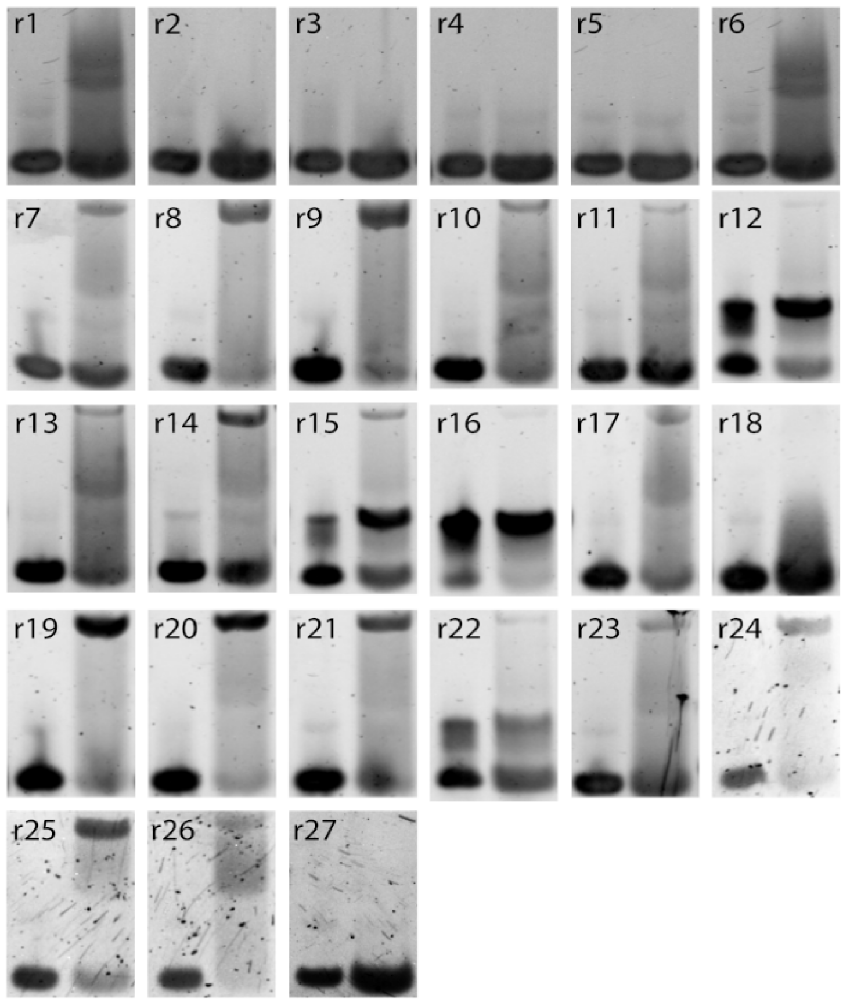
Fig 6. Experimental measurements of binding of respective designed sequences (r1 to r27) to thrombin. 5% native gel assay at 15˚C of stem loops (1–27) alone in the presence of Mg 2+ /K + (lane 1) and allowed to mix with α -thrombin for 30 minutes at 25˚C on the bench (lane 2). r12, r15, r16, and r22 aptamers were forming dimers with themselves but upon using samples without K + , they were found to bind thrombin. Their entries above display the successful attempt (see Methods for further details). Aptamers r1 and r6 did not show a clear upper band that is indicative of thrombin- aptamer dimer, but the observed smear might indicate weak interactions with the thrombin.